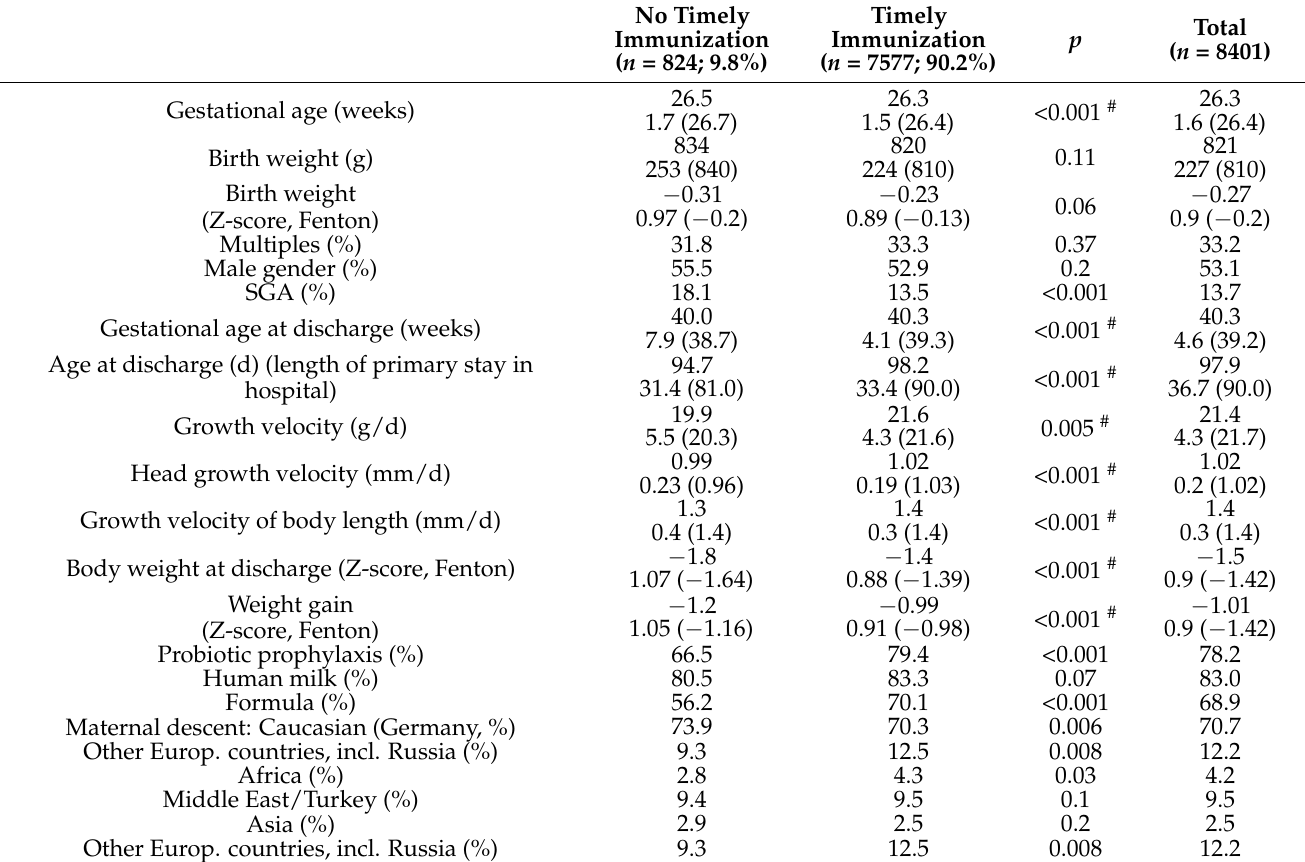
Table 1. Clinical characteristics stratified to timely pneumococcal and hexavalent